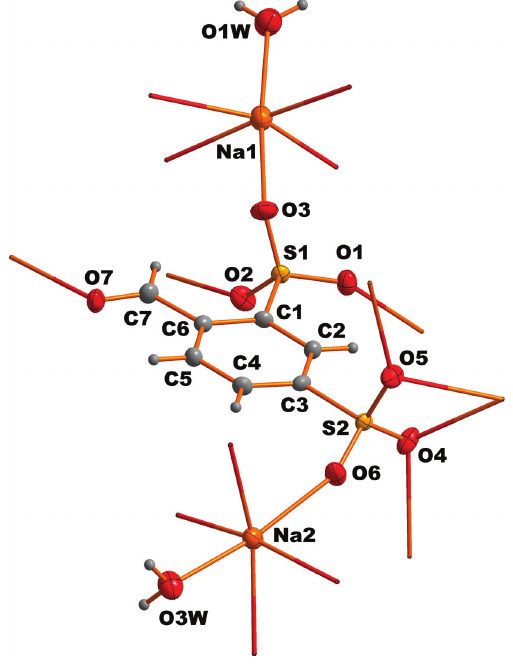
Table 1: Data collection and handling.